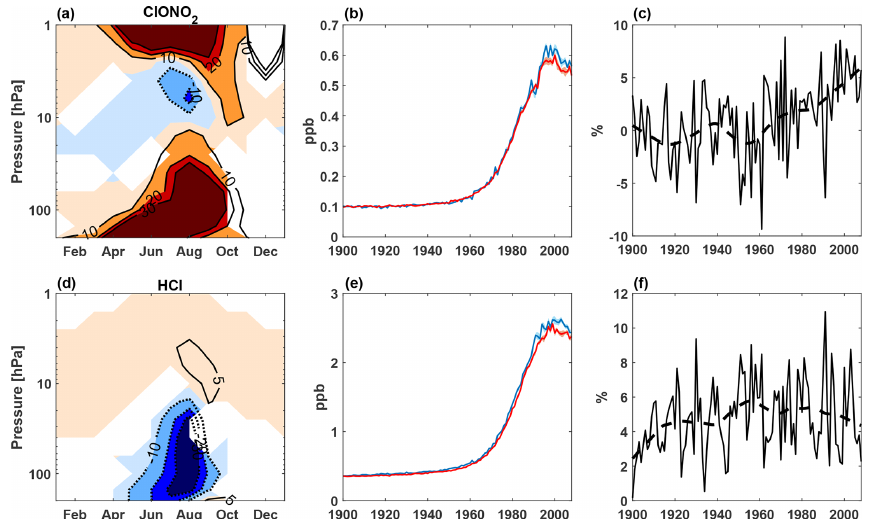
Figure 8. (a) Relative difference (EXP − REF) / REF in the monthly zonal mean polar ClONO 2 (70–90 ◦ S, 1–200hPa) during 1979–2008. Positive contour levels (solid lines) are 10%, 20% and 30% and the negative contour level (dotted line) is − 10%. Colour shading indicates areas significant at the 95% level, calculated with a Monte Carlo simulation and a false detection rate. (b) September–October ensemble mean time series of polar ClONO 2 (70–90 ◦ S, 10–20hPa) in EXP (blue) and REF (red). Shaded light blue and red areas represent 95% confidence intervals of ensemble means. (c) Relative difference of EXP and REF (solid line) and 31-year smooth trend (dotted line). (d) Polar HCl with negative contour levels of − 10%, − 20% and − 30% (dotted lines) and positive contour level of 5% (solid line). (e, f) This is the same for HCl as (b) and (c) ,